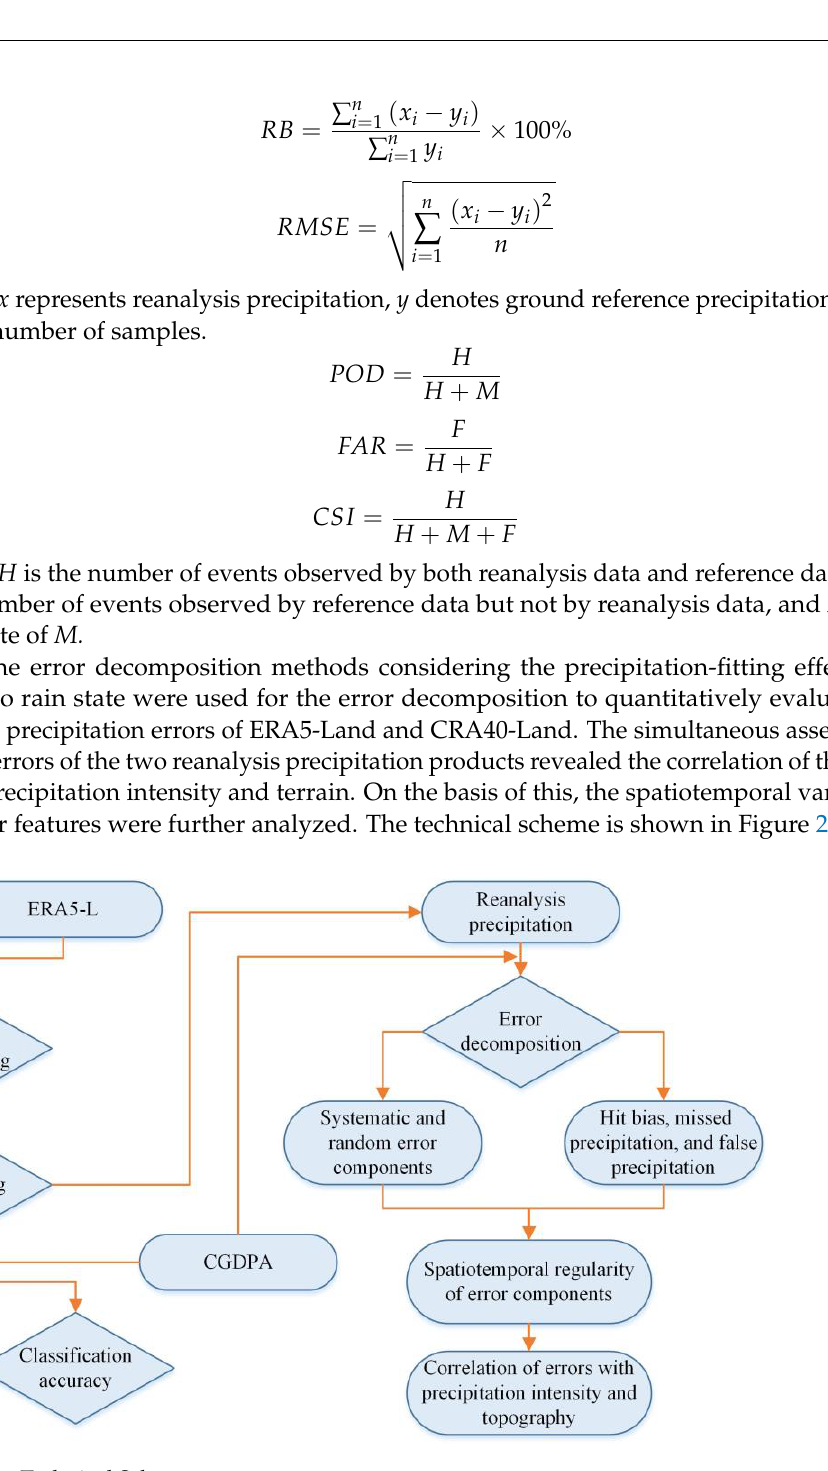
Figure 2. Technical Scheme.